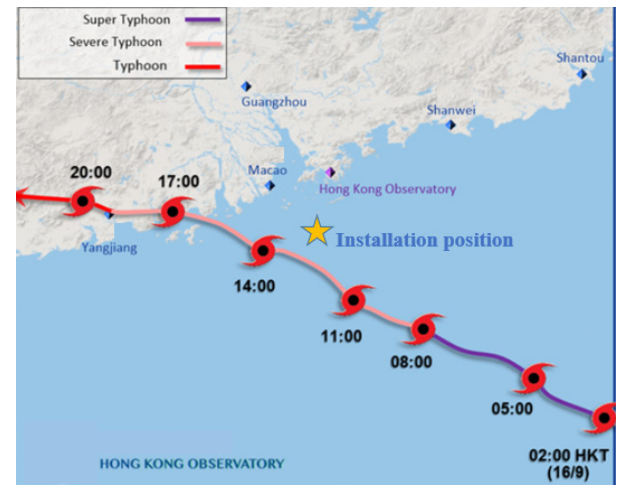
Figure 1. The track of Typhoon Mangkhut.